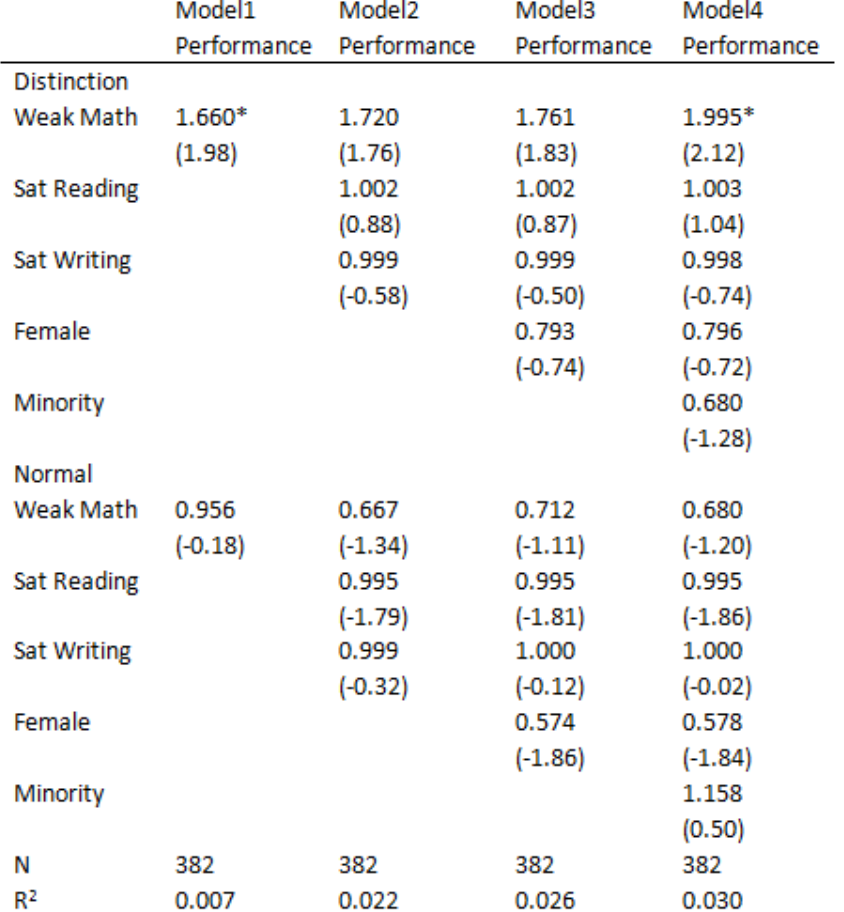
Multinomial Logistic Regression Predicting UCI Bio 93 Students’ MOOC